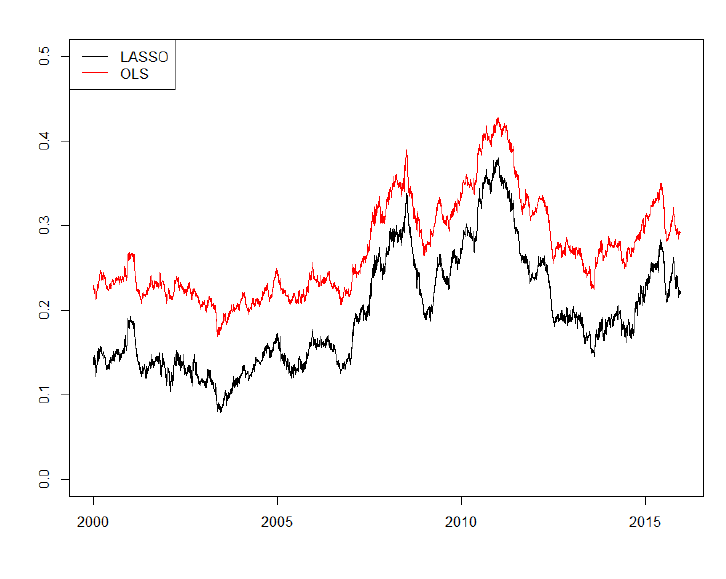
Figure 1A: Dynamic total implied volatility spillover index for seven asset classes (the lasso method and the OLS method)